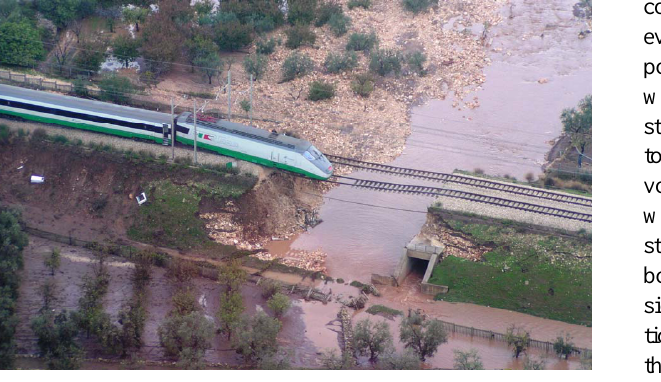
Figure 3. View of the breach developed in the Acquaviva railway embankment (point 4 in 2 Fig. 3. View of the breach developed in the Acquaviva railway em- Figure 4) after 5 October 2005 flooding (picture taken from the upstream side) . 3 bankment (point 4 in Fig. 4) after 5 October 2005 flooding (picture taken from the upstream